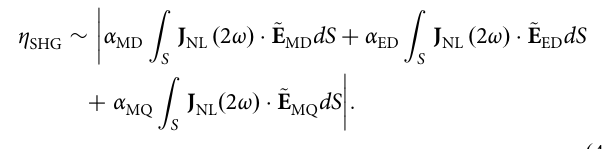
the participating frequencies. The highest SH ef fi ciency is estimated at 3 : 4 ´ 10 (cid:3) 10 , at incident peak power of 4.3 kW, beam FWHM of 4.6 µm, see Supplementary Fig. 3 of Supplementary